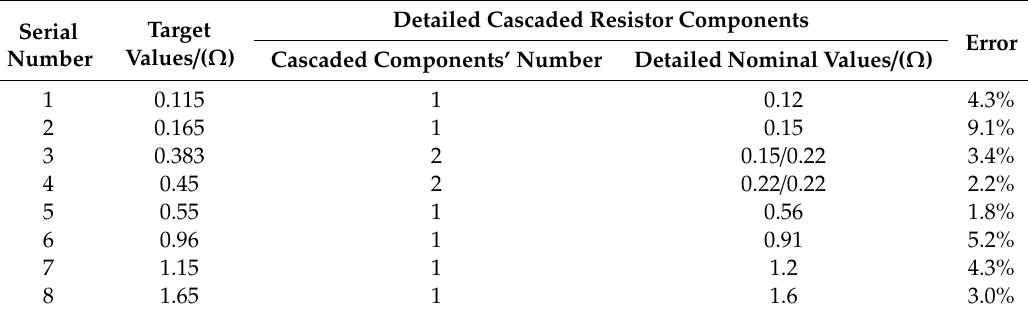
Table 5. Detailed cascaded resistor components to form the required resistor.